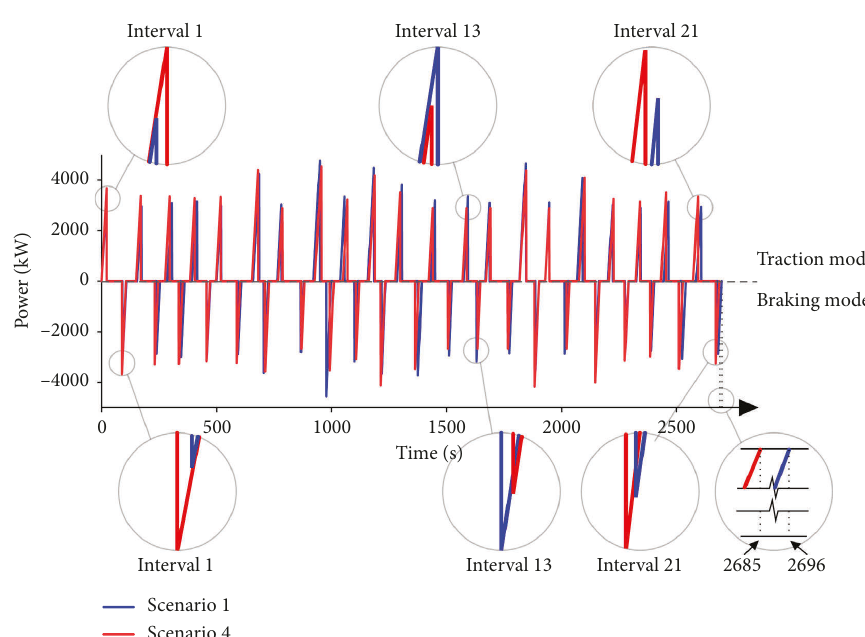
Figure 9: Comparison of the power curves of the train departing at 17:03 in the upstream direction in Scenario 1 and Scenario